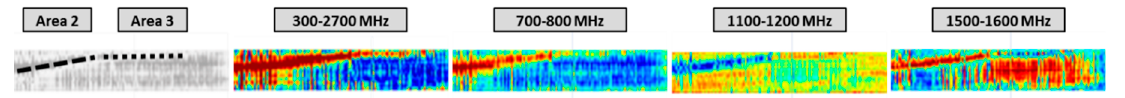
Figure 13. Radar response comparison for the highlighted feature with varying frequency interval.